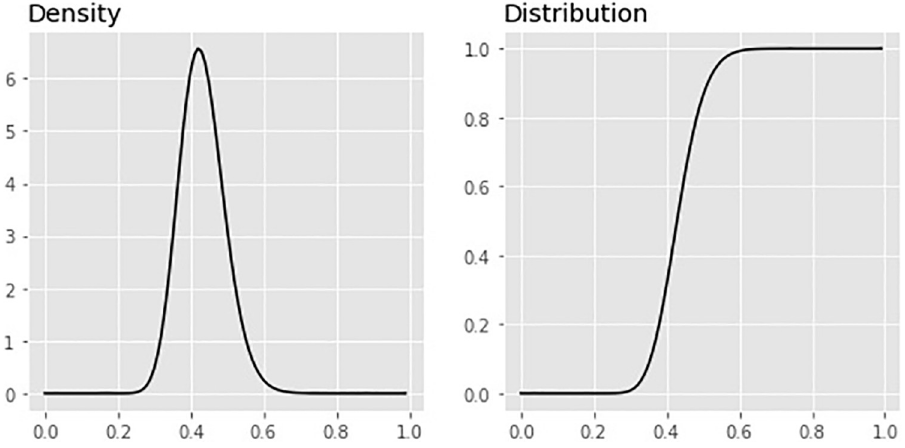
Fig 2. Plot of ratio density and distribution. Plot of f ( z ) prior density Eq (2) and F ( z ) posterior distribution Eq (3) for the Black Death plague data from Table 2 with priors π 1 = π 2 = π 3 = π 4 = 0 as an example.